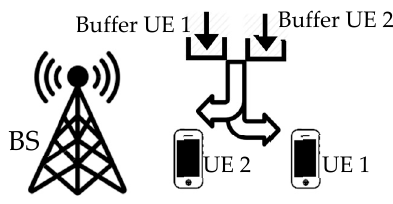
Figure 5. User-specific transmission bu ff er [20]. UE, user Figure 5. User ‐ specific transmission buffer [20]. UE, user equipment.